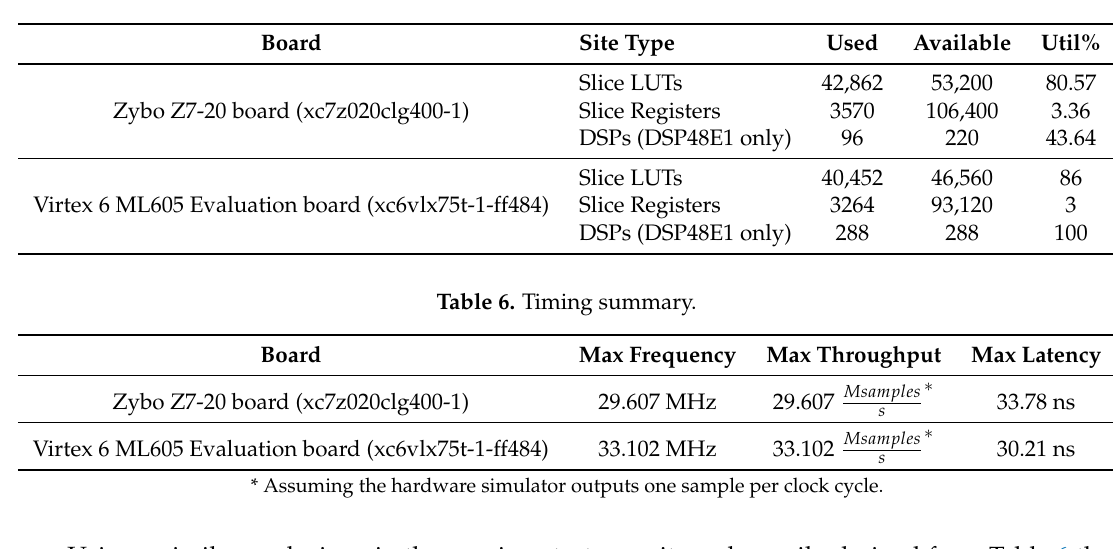
Table 5. Utilization results.